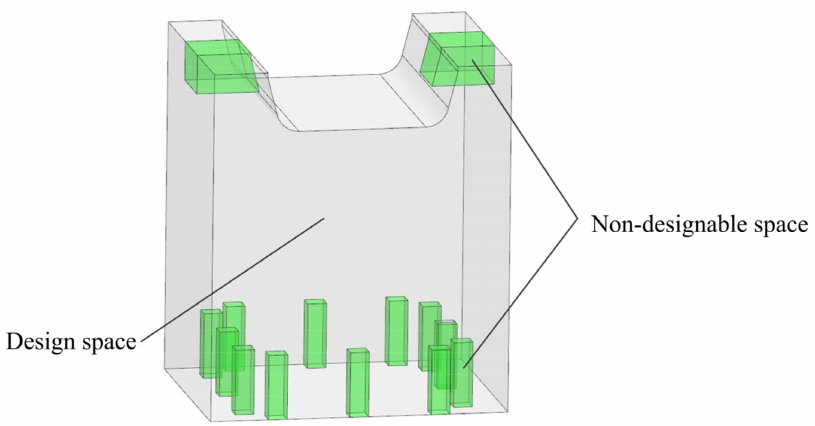
Figure 2. Geometric model for topology